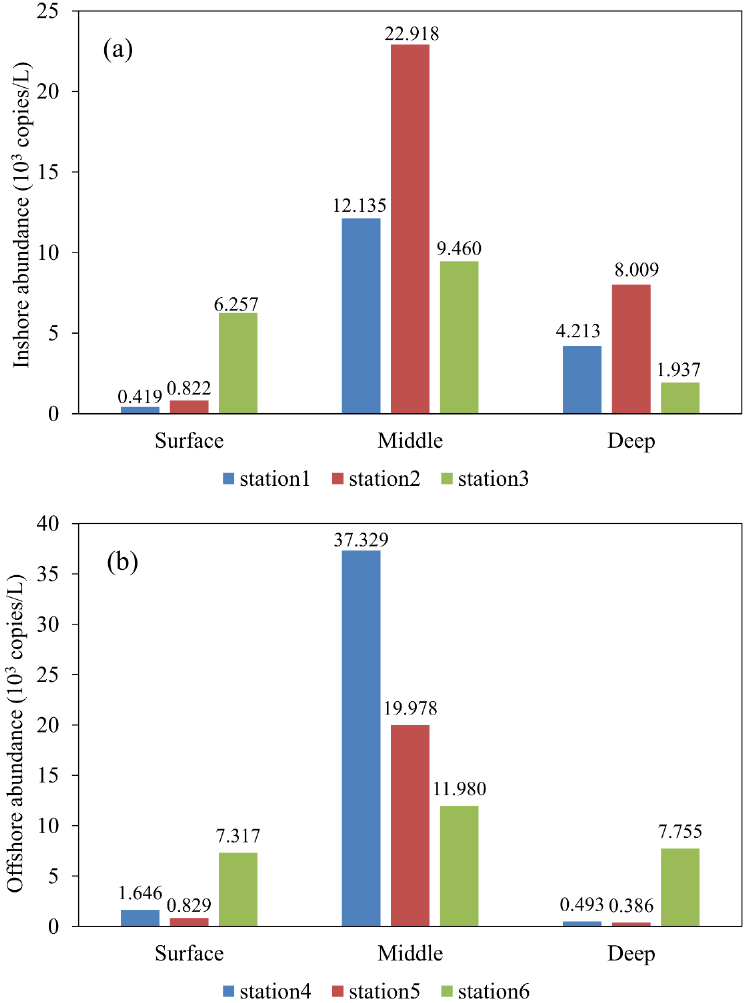
Figure 2. 18S rRNA gene abundance of Labyrinthulomycetes protists in the different zones of ( a ) inshore; and ( b ) offshore habitats.